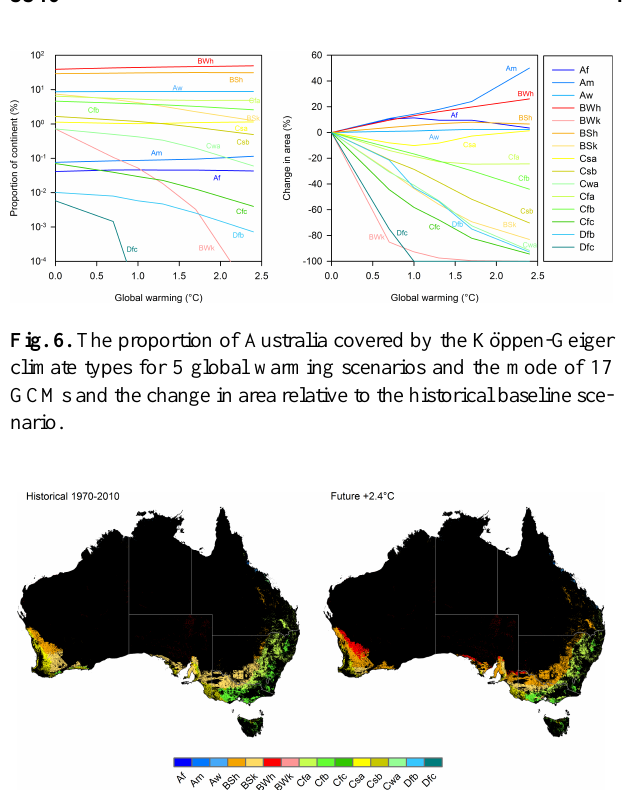
Fig. 7. Distribution of K¨oppen-Geiger climate types under the present extent of annual crops and pastures (BRS, 2008) (blacked out areas of the figure do not have annual vegetation).